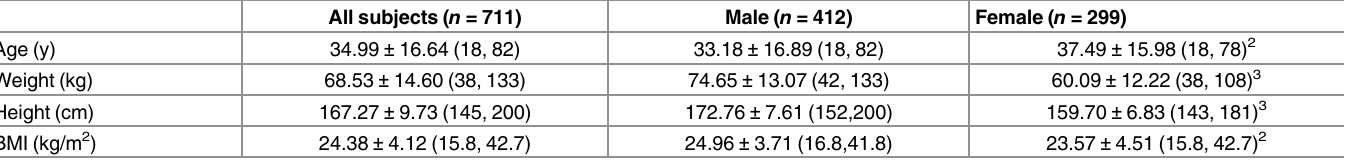
Table 1. Physical characteristics of the subjects 1 .